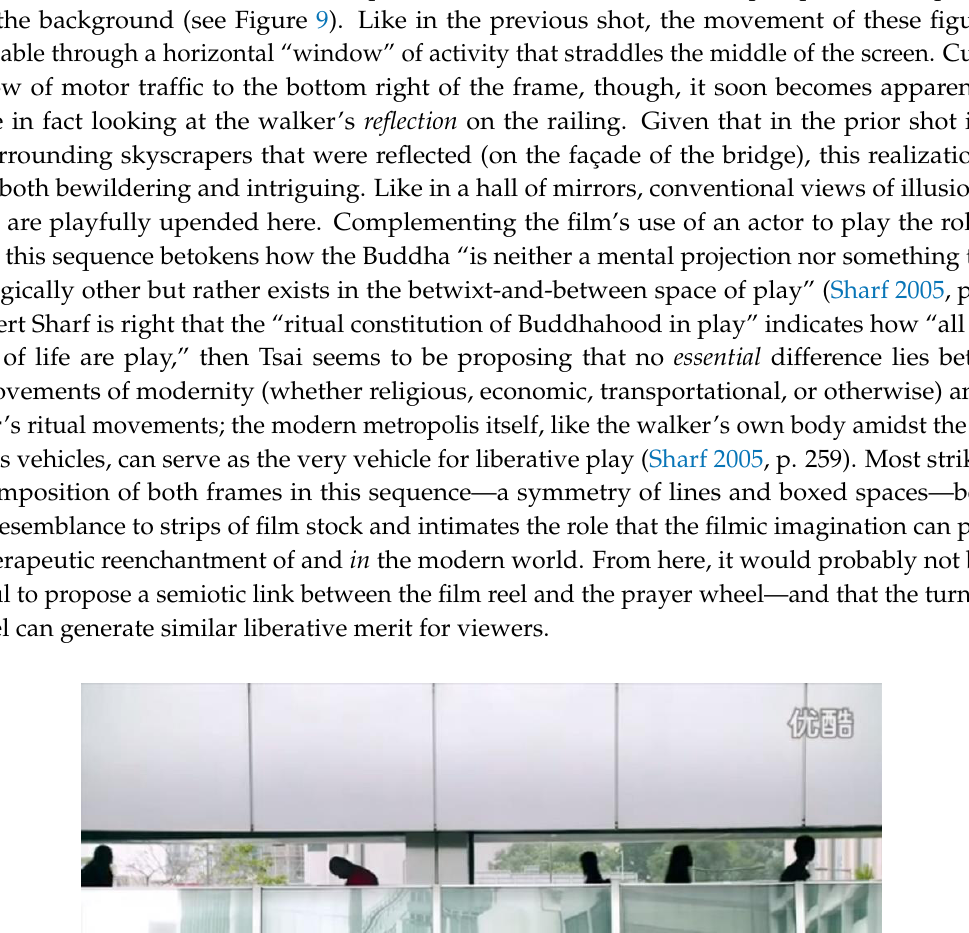
Figure 9. A window of reflection. Having traversed the myriad terrains of the city, the walker’s journey finally comes to a stop in the penultimate shot. Flanked by two stacks of undelivered newspapers that signal an impending dawn, he finds himself halted in front of firmly-locked metal grills. To the extent that the walker’s journey hitherto this point has partaken in the toils and travails of modern life, his stopping before a “NO ENTRY” sign—like the empty scriptures that Wu Cheng’en’s Xuanzang initially obtains when he finally arrives in India—allegorizes the Zen dictum that one need not search or travel far for deep meaning and fulfilment. In the walker’s decisive stillness, he embodies an admonition from Linji Yixuan (fl. 9th century) that applies as much to moderns as it does to monastics: “What are you seeking as you go around hither and yon, walking until the soles of your feet are flat? There is no Buddha to seek, no Way to attain, no Dharma to obtain” (Sasaki 2009, p. 27). Accepting that he can proceed no further than where he already is, in the last shot the walker begins to eat the bun that he has been holding in his hand all this while (see Figure 10). In his slow, simple mastication, the “prospect of vitality” (Duffy 2009, p. 7) and “heightened, intensified way of life” (Jones 1915, p. 157) driving the modern fetishization of speed finds an alternative telos in what we might call the mysticism of the mundane. Here, Tsai is in concert with contemporary proponents of mindful eating, who identify this practice as an ideal path through which human appetites can “be transformed from a source of suffering to a source of renewal, self-understanding, and delight” (Bays 2009, p. 5). By affirming and appreciating basic physiological activities like walking and eating, the film seems to say, moderns can rediscover the sheer joy of simply being alive.